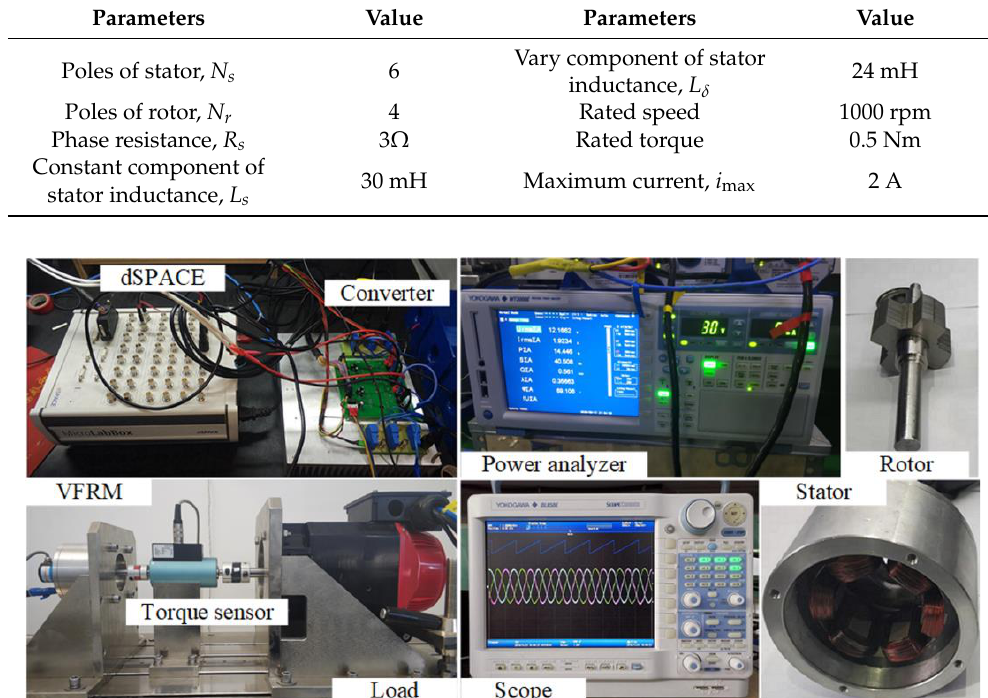
Figure 8. Photo of the experimental